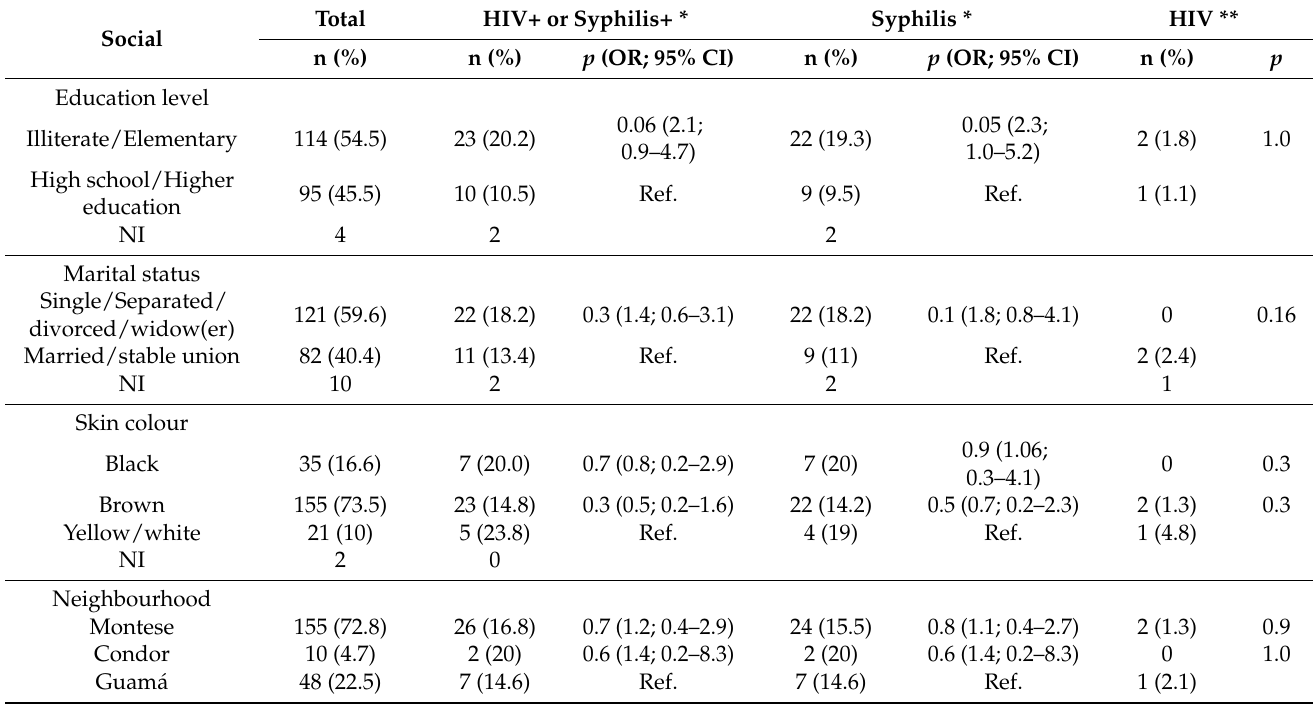
Table 1. Social factors associated with sexually transmitted infections in the elderly in a subnormal agglomeration in the Brazilian Amazon.